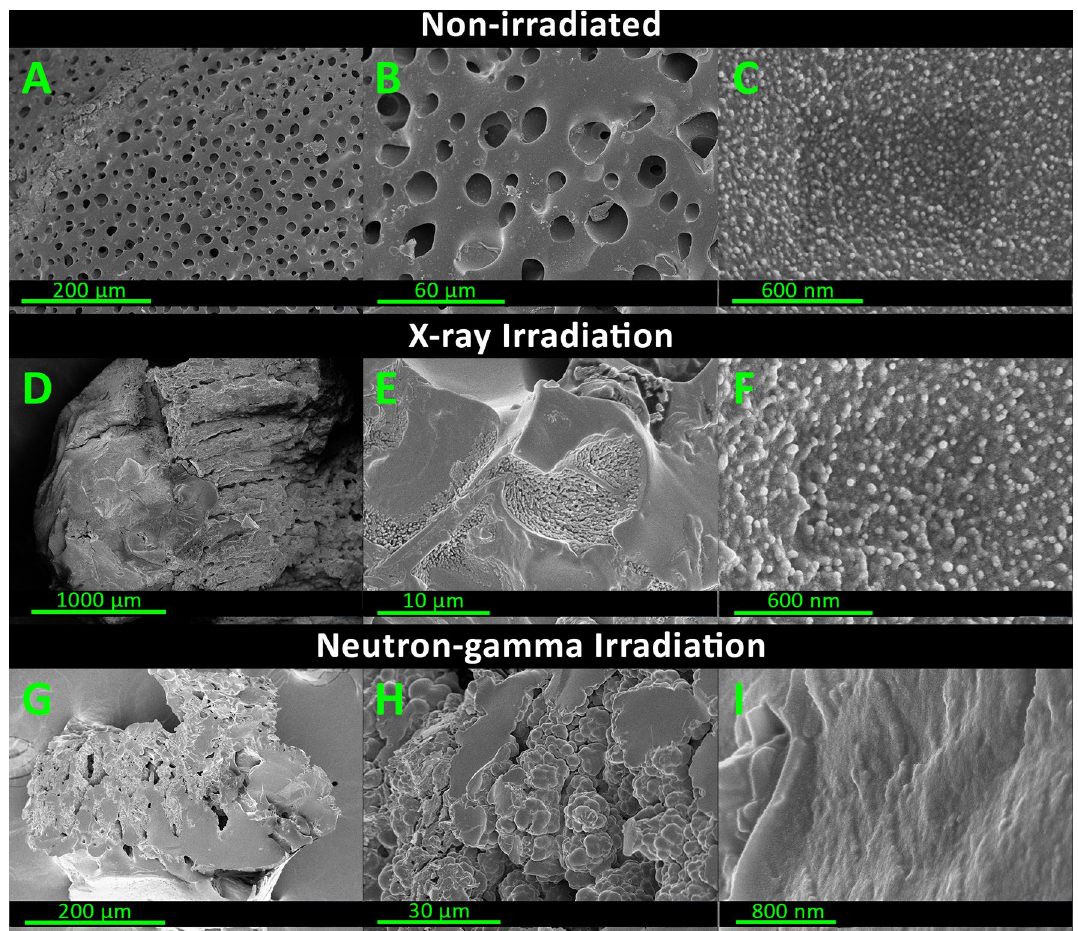
10 B samples irradiated at different